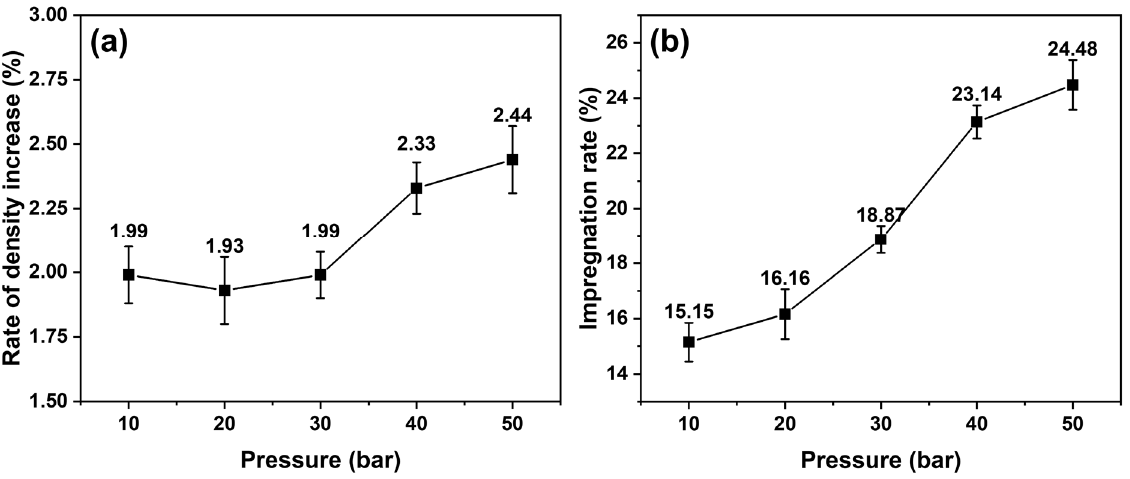
Figure 2. ( a ) Density rate increase and ( b ) impregnation rate of impregnated graphite blocks at var- ious impregnation